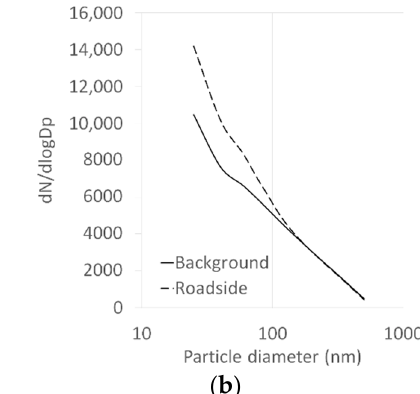
Influence of PM 10 mass concentrations